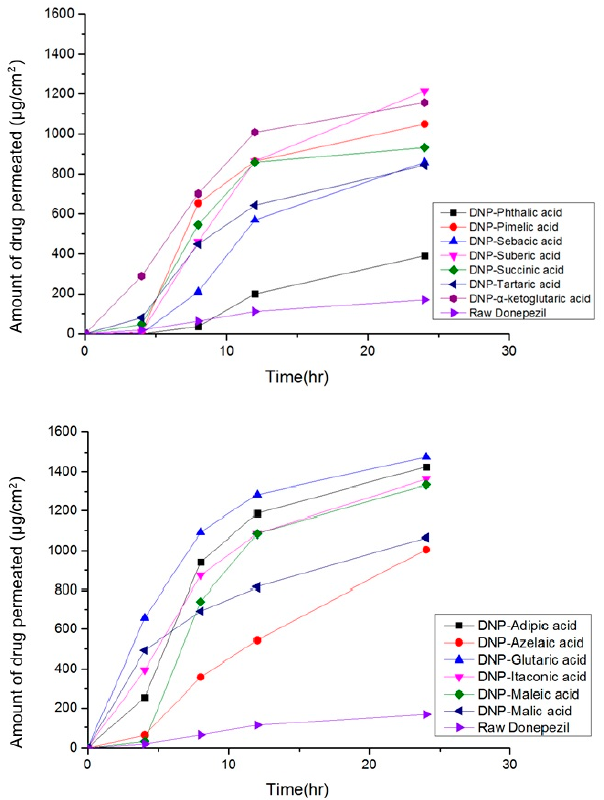
Figure 6. Results of skin permeation test of donepezil and various conformers ionic liquids prepared using different co-formers and donepezil (mean, n = 3).